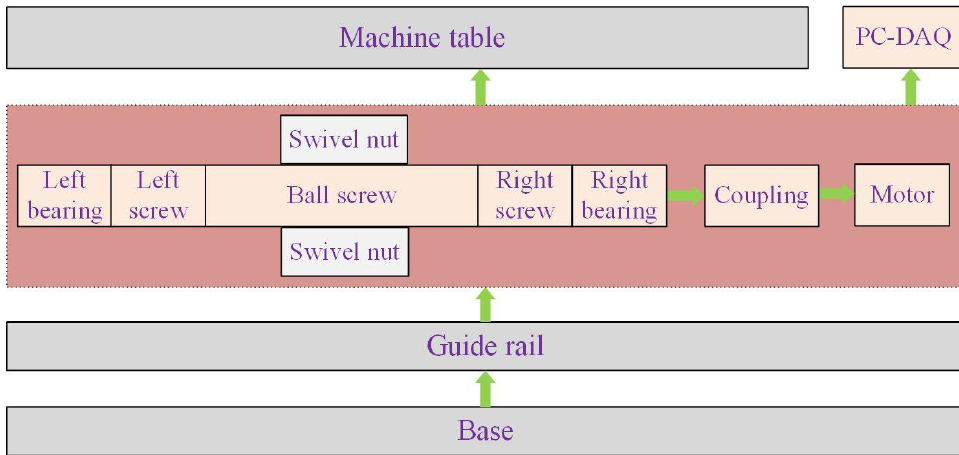
Figure 1. Diagram of internal heat source components of CNCME.